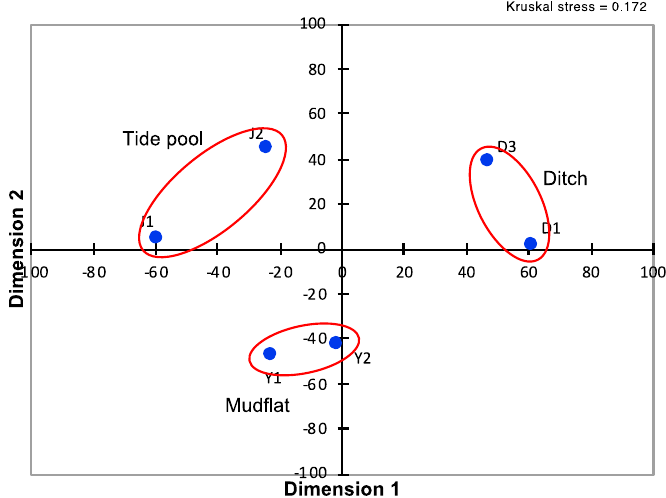
Figure 6. Multidimensional scaling of D matrix data showing differences in pufM phylotype composition among the six selected samples taken from mudflat (Y1 and Y2), tide pools (J1 and J2), and wastewater ditches (D1 and D3). The distance between samples are shown by blue dots.